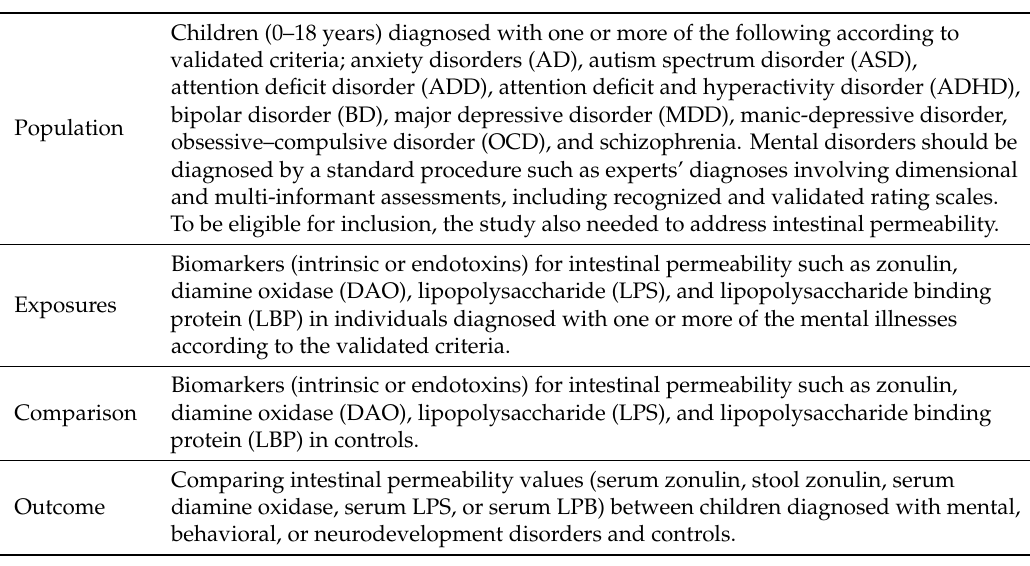
Table 1. Inclusion criteria based on the PICO